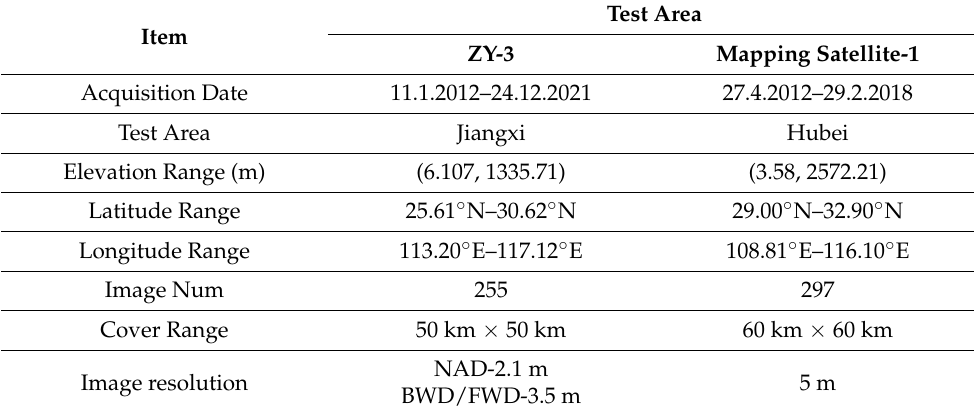
Table 1. Basic parameters of test area.